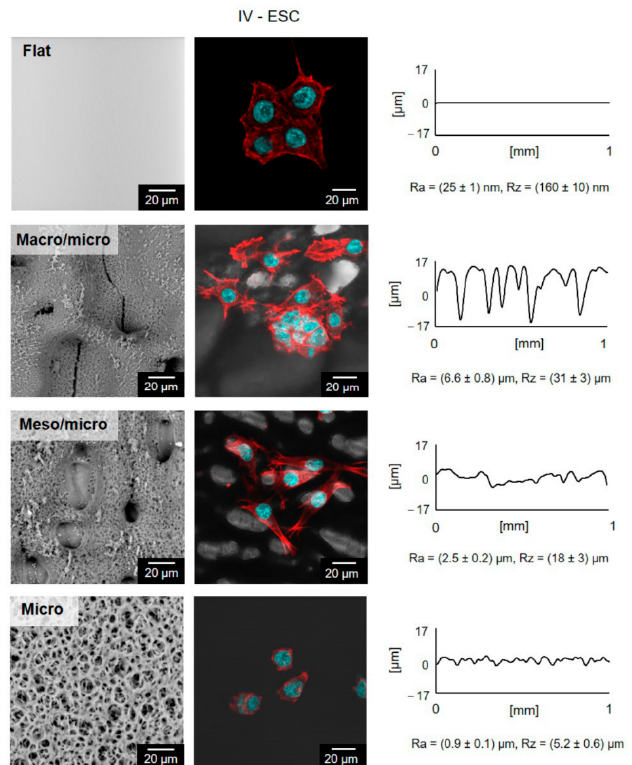
Figure 5. Embryonic stem cells (ESC) on the structured PS, column IV. Blue marked cell nuclei (Hoechst), red cytoskeleton (ActinRed). PS surfaces prepared by one or more stepwise time-sequenced phase separation (Macro/Micro and Meso/Micro) correspond to Figure 2. PS foam (Micro) prepared by phase inversion corresponds to Figure 3. Images from the SEM on the left, from the confocal microscope in the middle, and from the contact profilometer on the right.